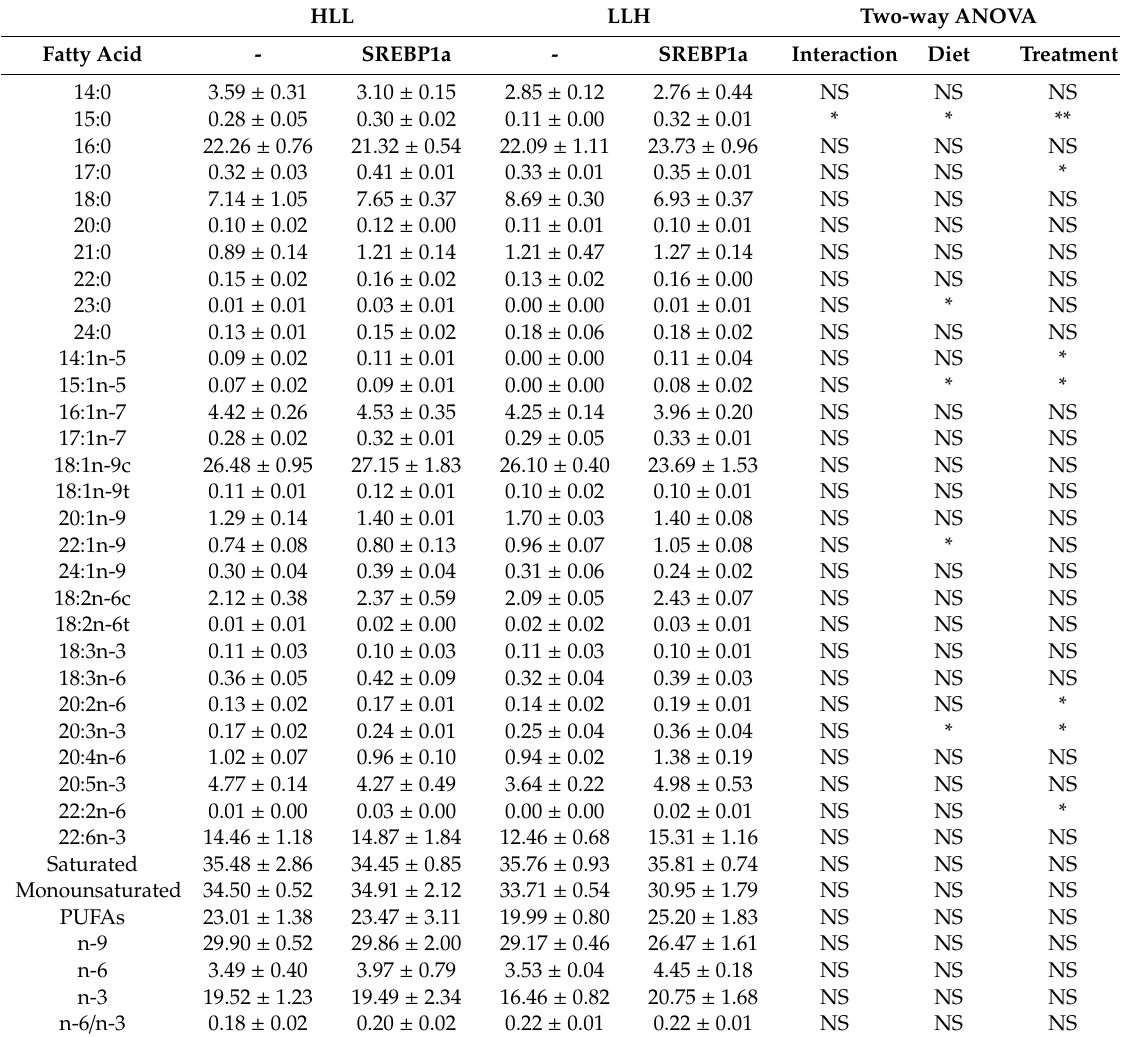
Table 4. E ff ect of SREBP1a overexpression on fatty acid profile in the liver of S. aurata